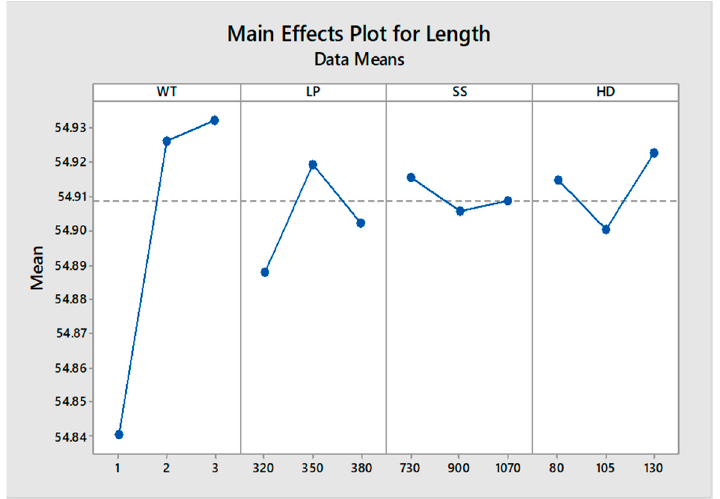
Figure 9. Main effects plot for length.